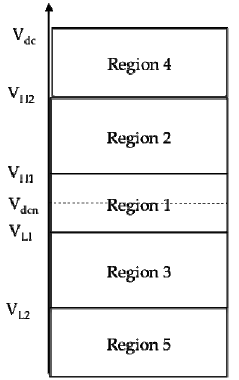
Figure 3. Operation regions of DC bus voltage.